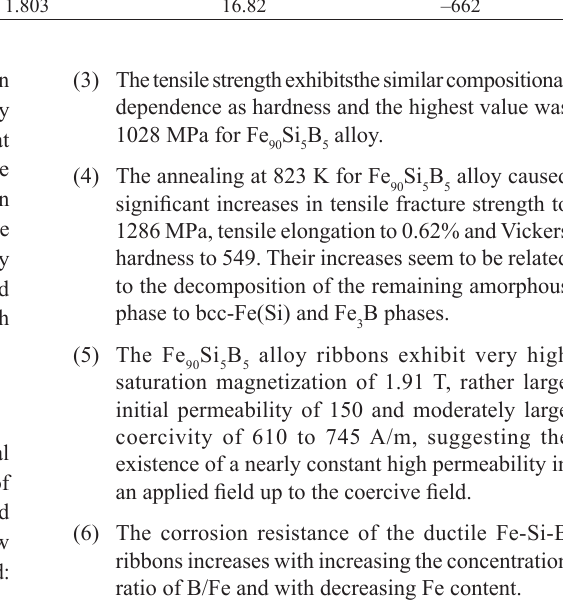
Corrosion rate (gm –2